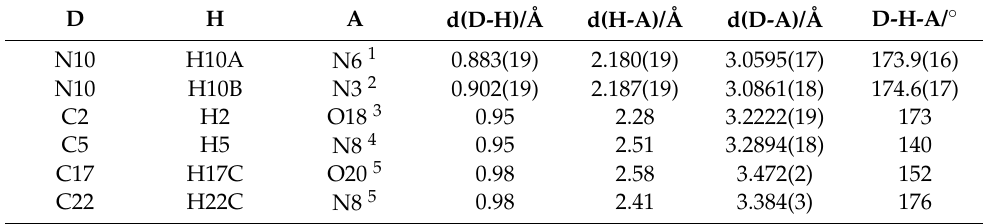
Table 1. Hydrogen bonds in crystal structure of anhydrous famciclovir (form